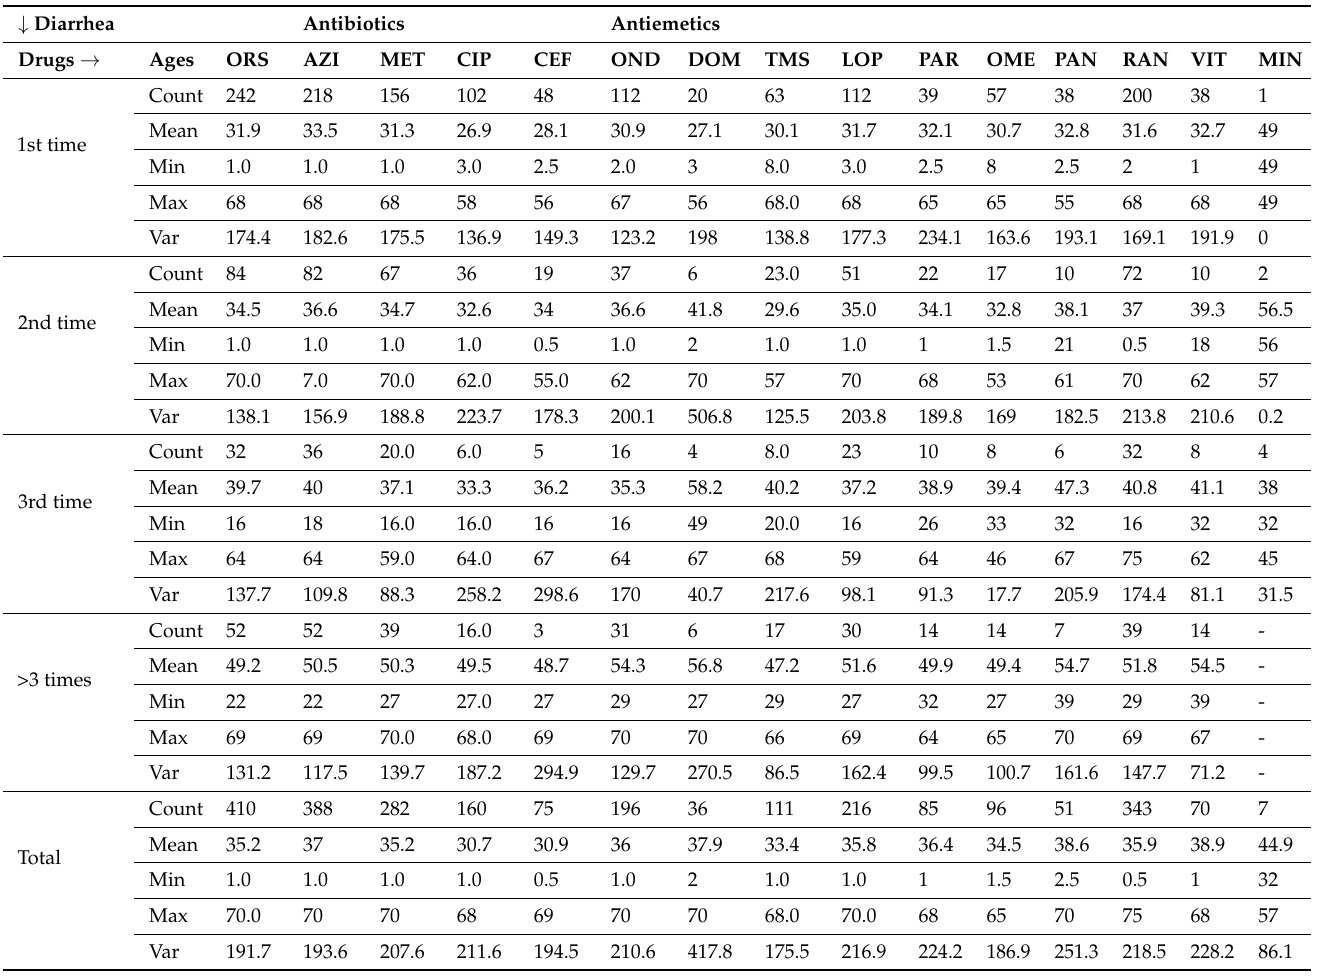
Table 9. Data classification on different types of drug prescriptions given to patients based on suffering